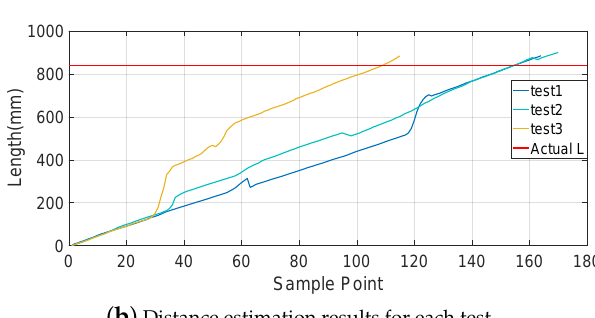
( a ) Trajectory of Experiment in GI phantom.